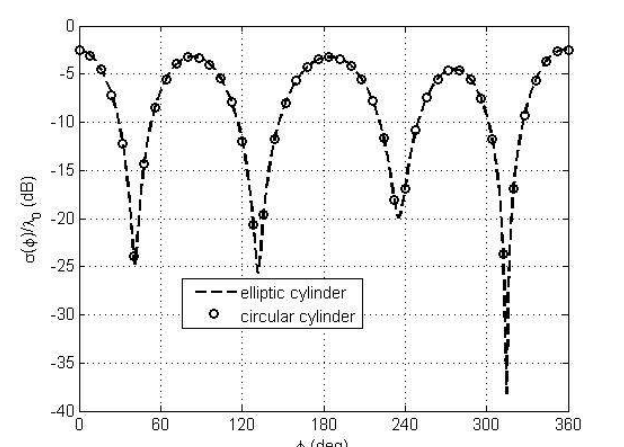
Figure 2: Variation of the normalized bistatic width with the scattering angle, for a G-type elliptic cylinder of axial ratio 1.0001 and 𝑘 with 𝜀 and 𝜇 , ! 𝑎 = 𝜋/2 , !! = 4 , 𝜀 !! = 2 , !! = 2 when excited by a TE polarized wave incident at 0 ! . Circles show results for an analogous circular cylinder given in [12].